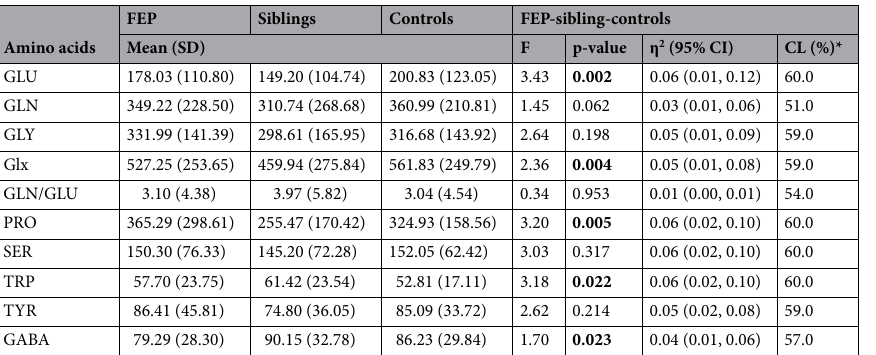
Table 2. The effect sizes and the common language effect size statistic correspondent between FEP-sibling- controls in relation to amino acid plasma profile. η 2 eta-squared (small: 0.01–0.05, medium: 0.06–0.13, large: ≥ 0.14), CI confidence interval, * CL common language effect size statistic. Bold: p ≤